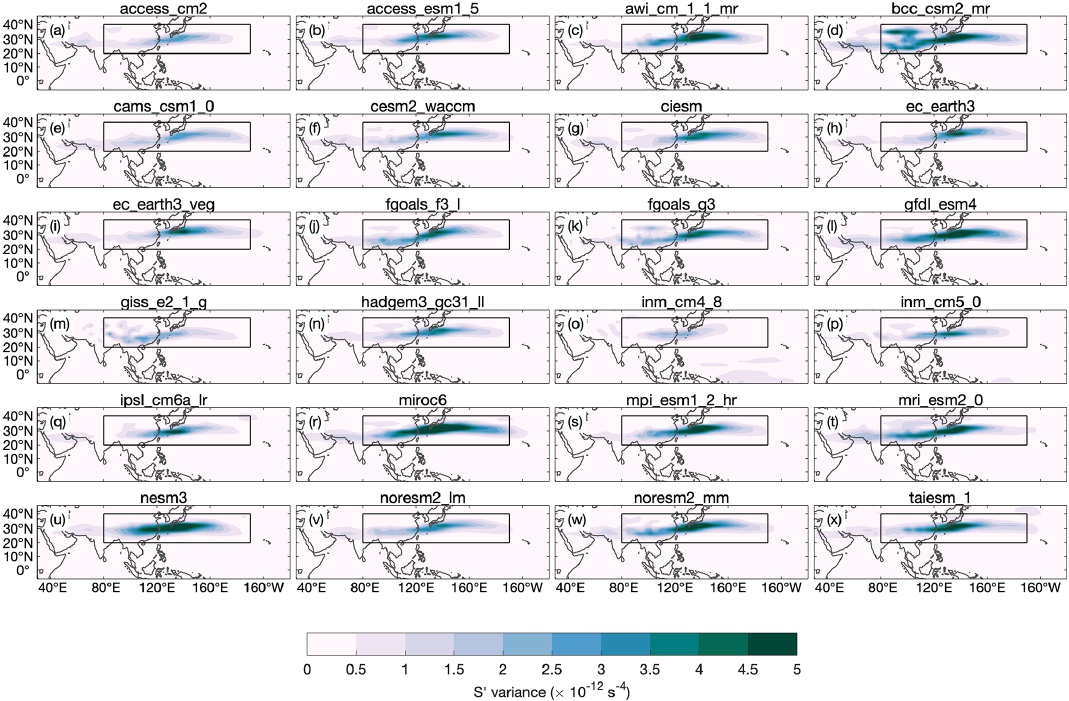
Figure A3. The temporal variance of the ensemble mean Rossby wave source ( S (cid:48) ) with the full mean states given by historical quantities. The box around the region (20–40 ◦ N, 80–190 ◦ E) indicates the region used for Fig. 5 of the main